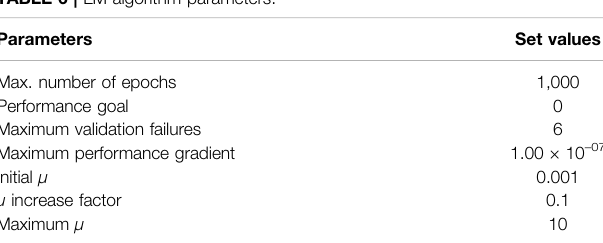
TABLE 6 | LM algorithm